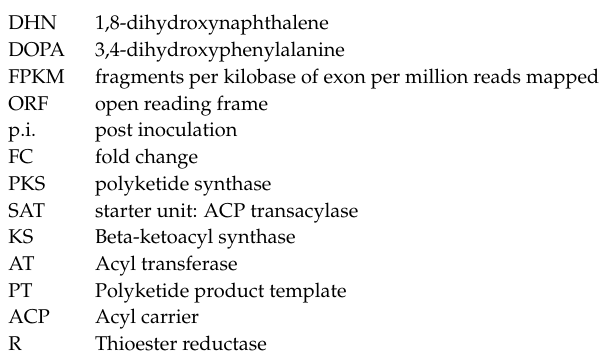
Figure S1: Sashimi plots of pgmB, pgmC, pgmR and pgmD genes of the pgm PKS cluster, Figure S2: Sashimi plots of pgmE, pgmF, pgmG and pgmH genes of the pgm PKS cluster, Figure S3: Sashimi plots of ATEG_06202 and ATEG_06212, Figure S4: Sashimi plots of the NRPS-like melanin biosynthase melA and tyrosinase tyrP , Figure S5: Detailed version of the phylogram in the Figure